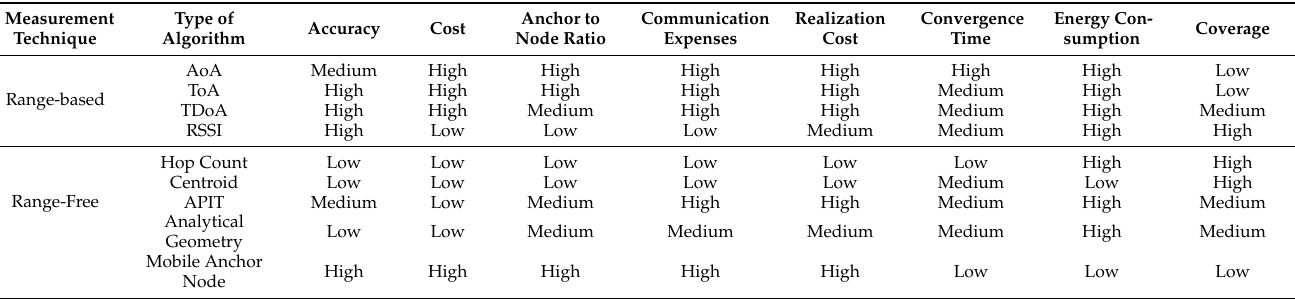
Table 4. Performance Comparison of Evaluation